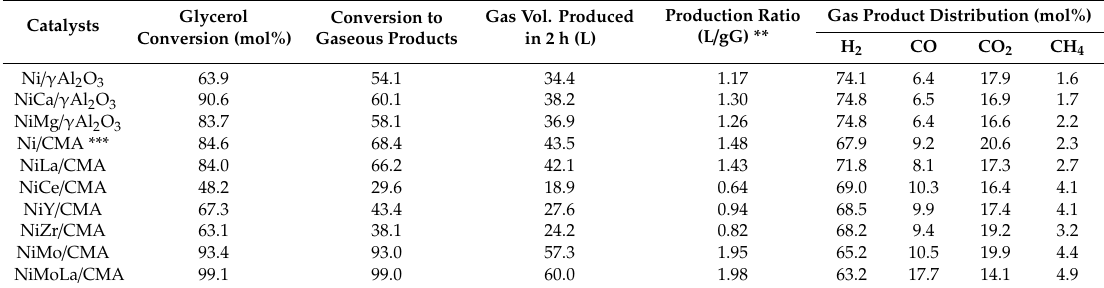
Table 8. Catalytic properties of different catalysts in SR of glycerol * [86] (used with copyright permission). Gas Vol. Produced Conversion to Catalysts Glycerol Conversion (mol%) in 2 h (L) Gaseous Products Ni / γ Al 2 O